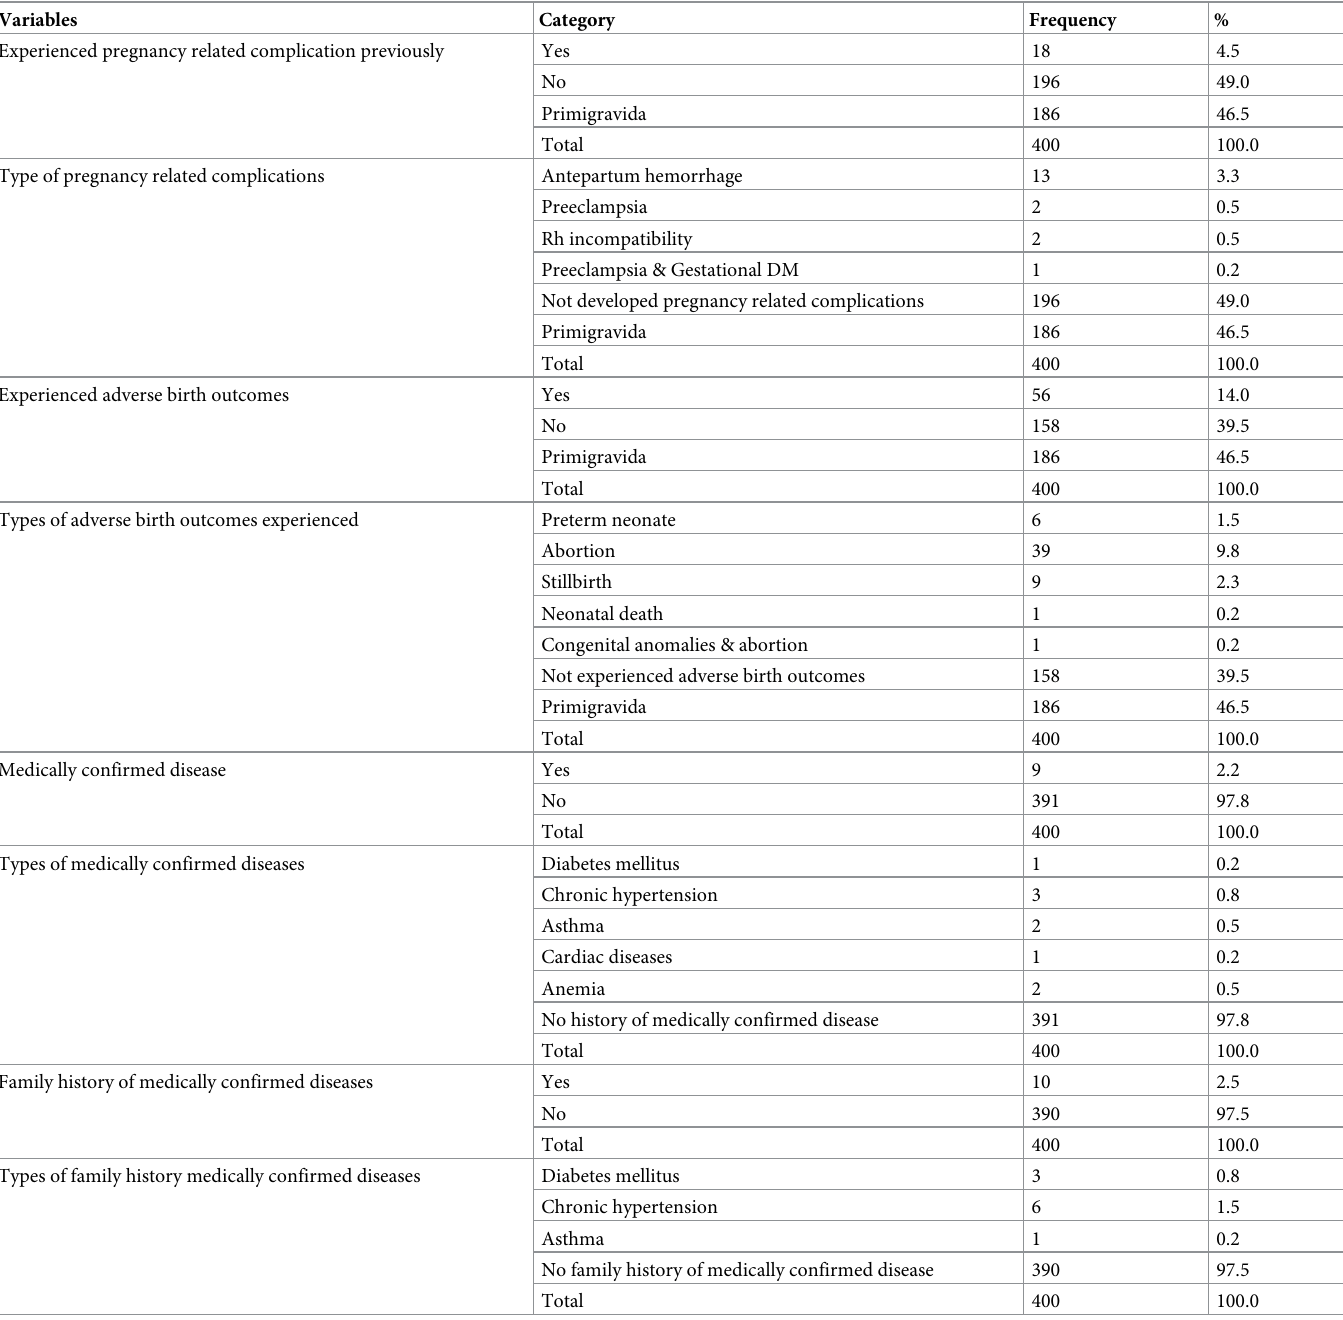
Table 3. Obstetrics and medical characteristics of women attending antenatal care clinics of public health facilities in Hossana town, Southern Ethiopia, 2020. Variables Experienced pregnancy related complication